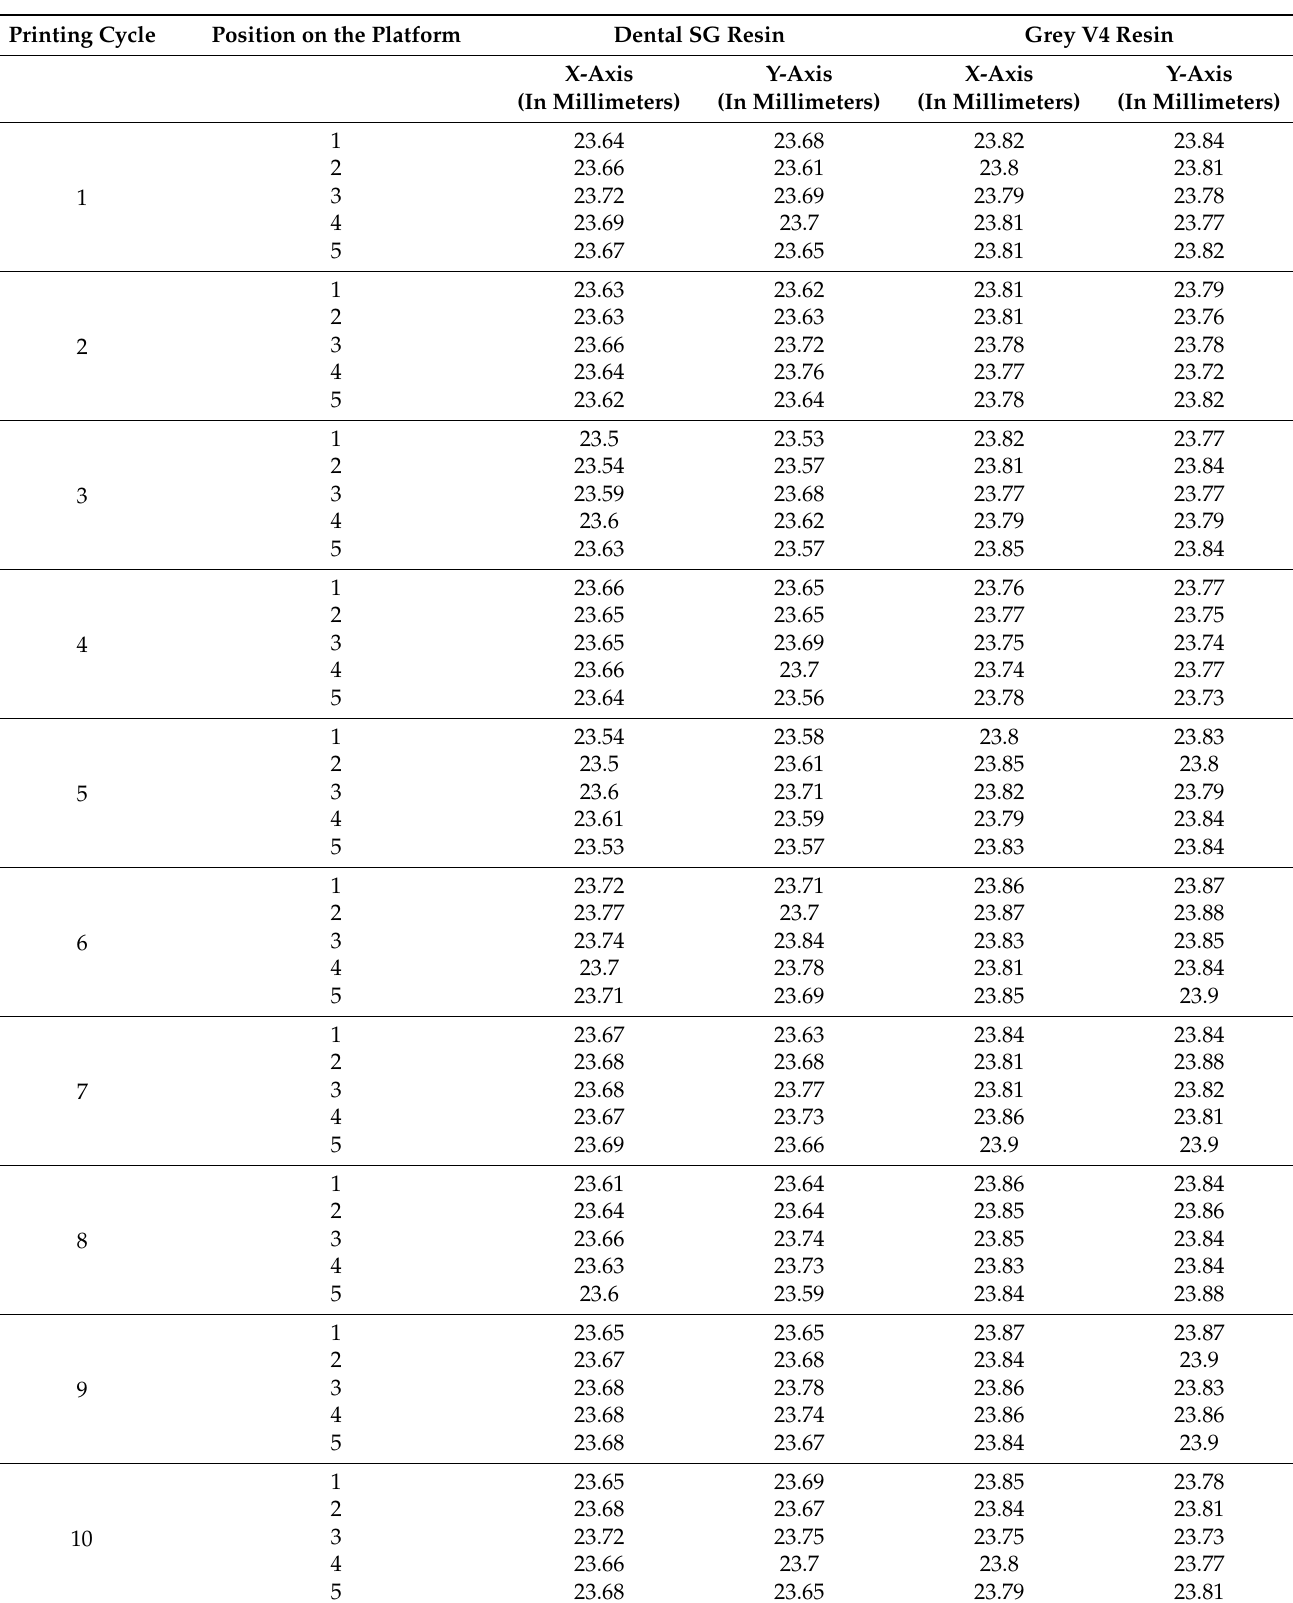
Table 2. X–Y axes measurements of the coupons printed in two resins (Dental SG and Grey V4, Formlabs, Somerville, MA, USA) at five different positions on the